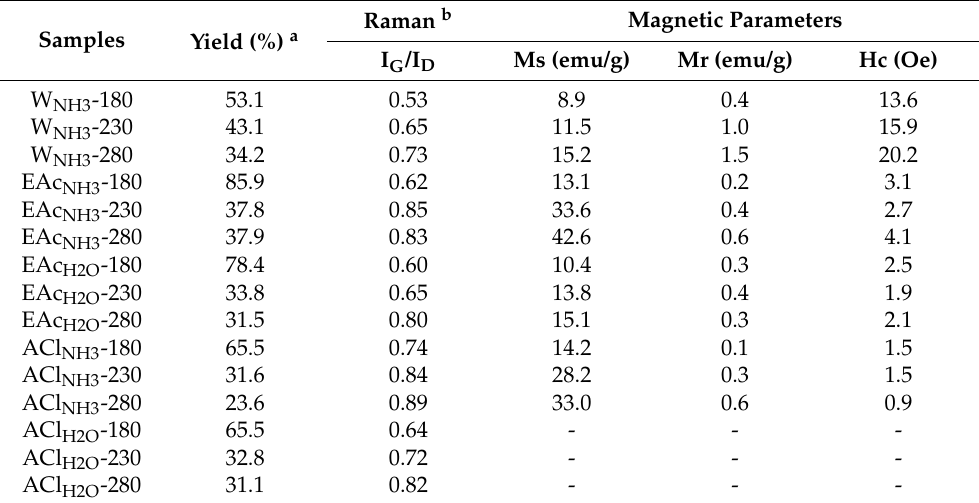
Figure 1. XRD patterns of the Fe 3 O 4 @C nanoparticles derived from holocelluloses ( A ), EmimAc ( B ) and AmimCl ( C ) dis- solved holocelluloses and regenerated in NH 3 · H 2 O. Table 1. Yields, graphite degree, and magnetic parameters of the Fe 3 O 4 @C nanoparticles.